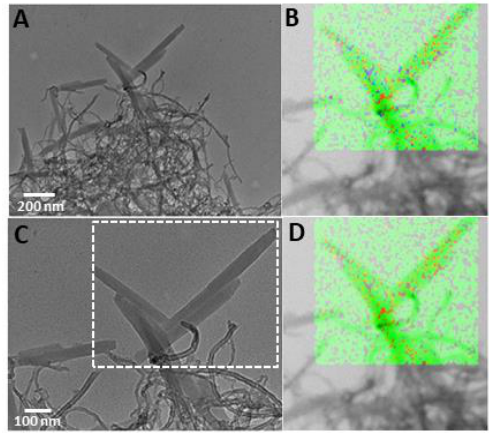
Figure 8. TEM images of MWCNT-EPA / TPPS J-aggregates at low ( A ) and high resolution ( C ): ( B , D ) corresponds to STEM analysis of total (C / N / O / S) and C / S merging of elements distribution respectively taken within the dashed region of the assemblies in ( C ) (for individuals colours of elements refers to ( B ) in Figure S3; see Materials and Methods for preparation conditions).